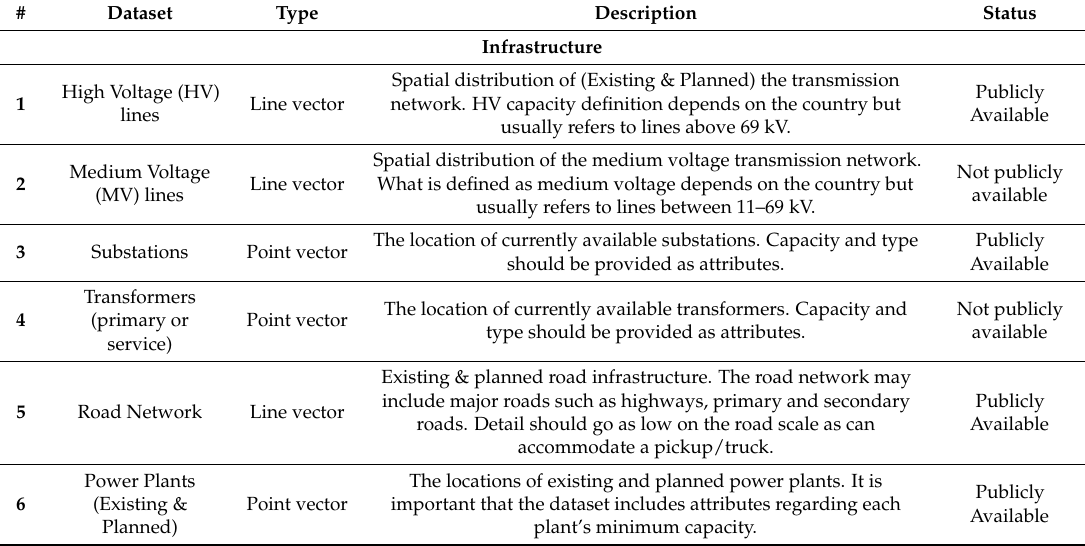
Table A1. GIS data gap analysis in electrification